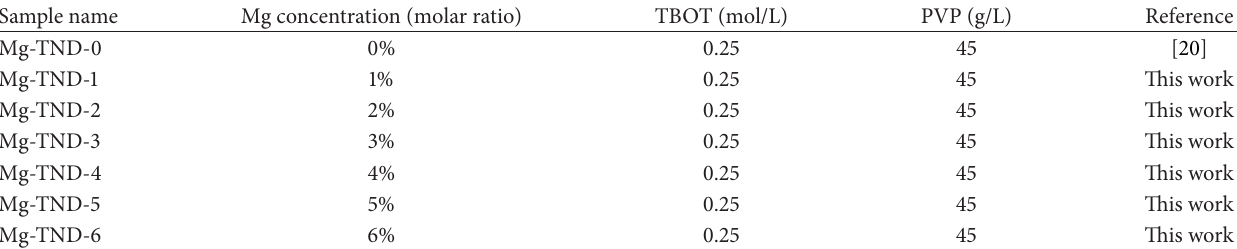
nanodots/Ti samples ∗ . 2